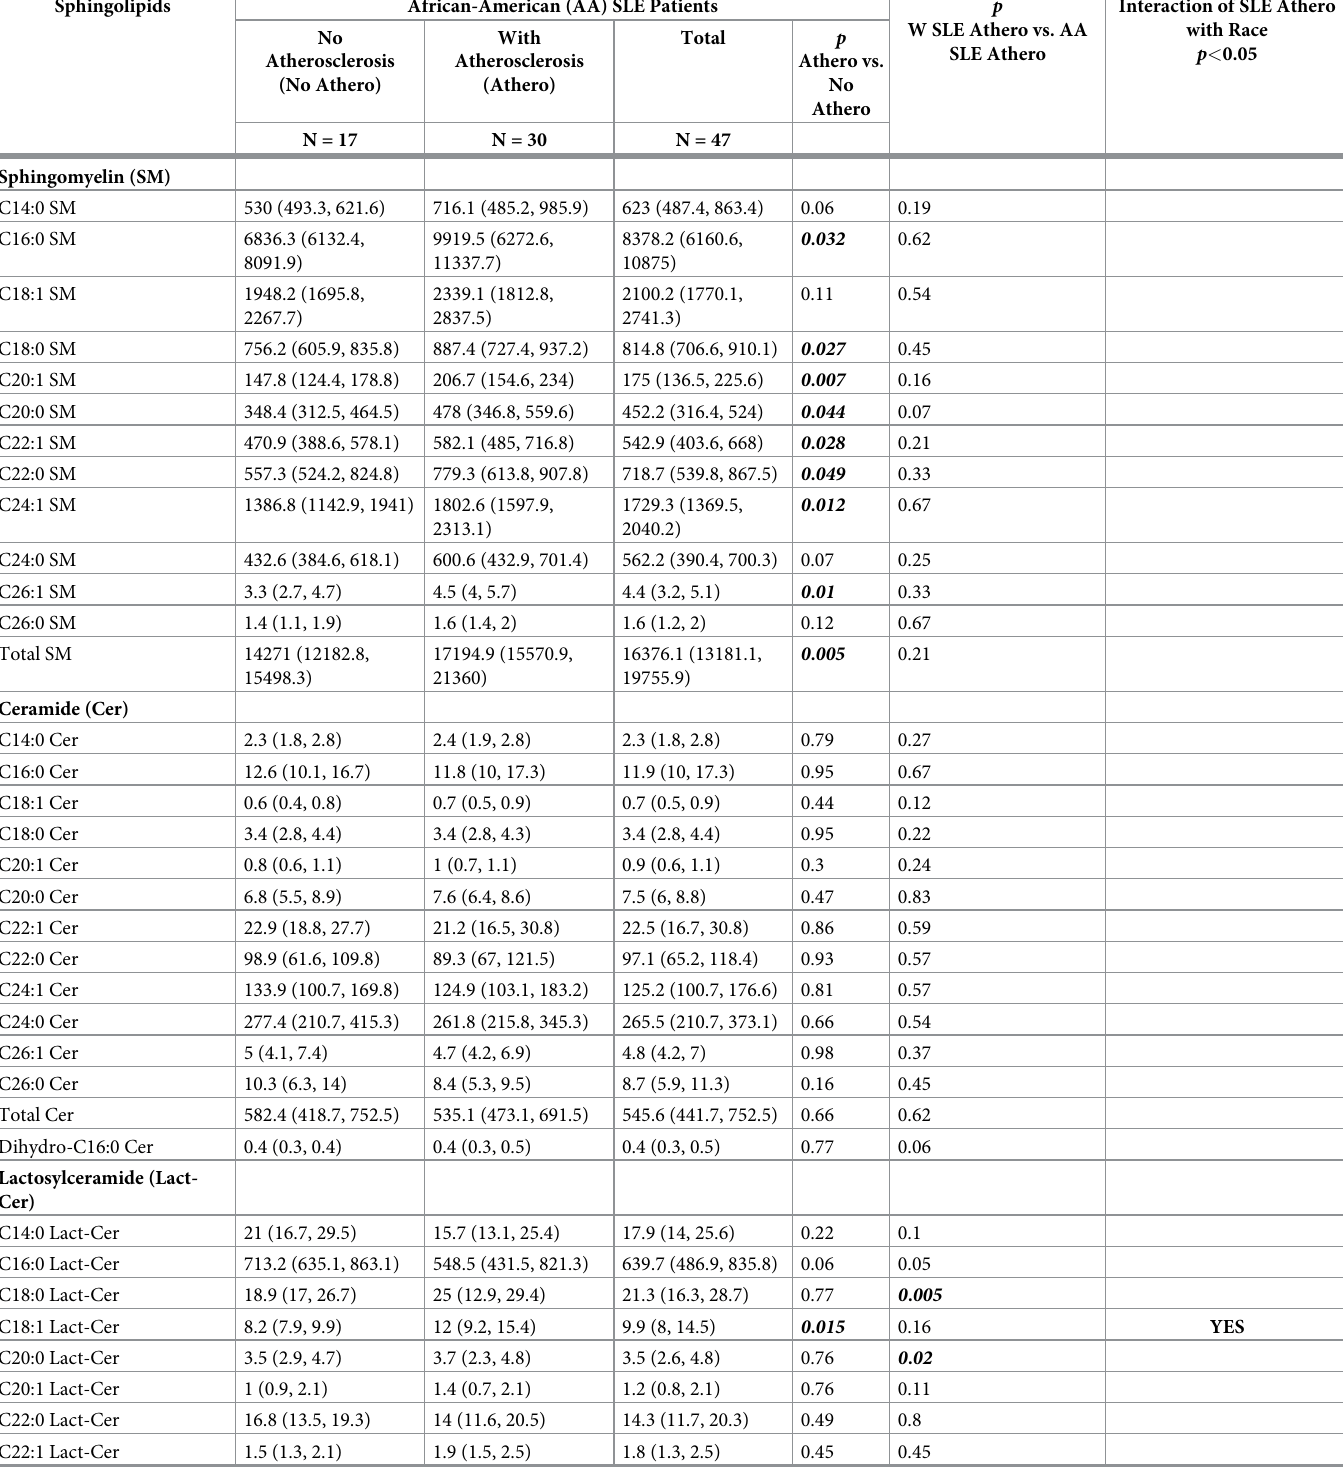
Interaction of SLE Athero W SLE Athero vs. AA with Race SLE Athero p <